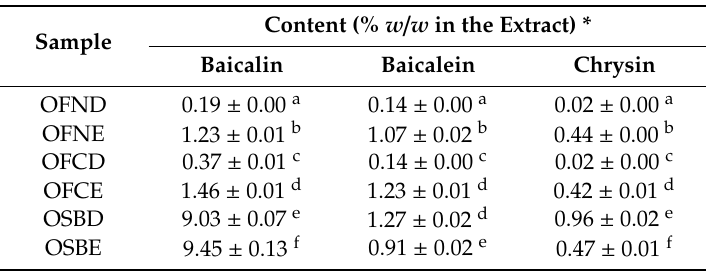
Flavonoid contents in O. indicum extracts determined by high-performance liquid chromatographic (HPLC). Content (% w / w in the Extract) Sample